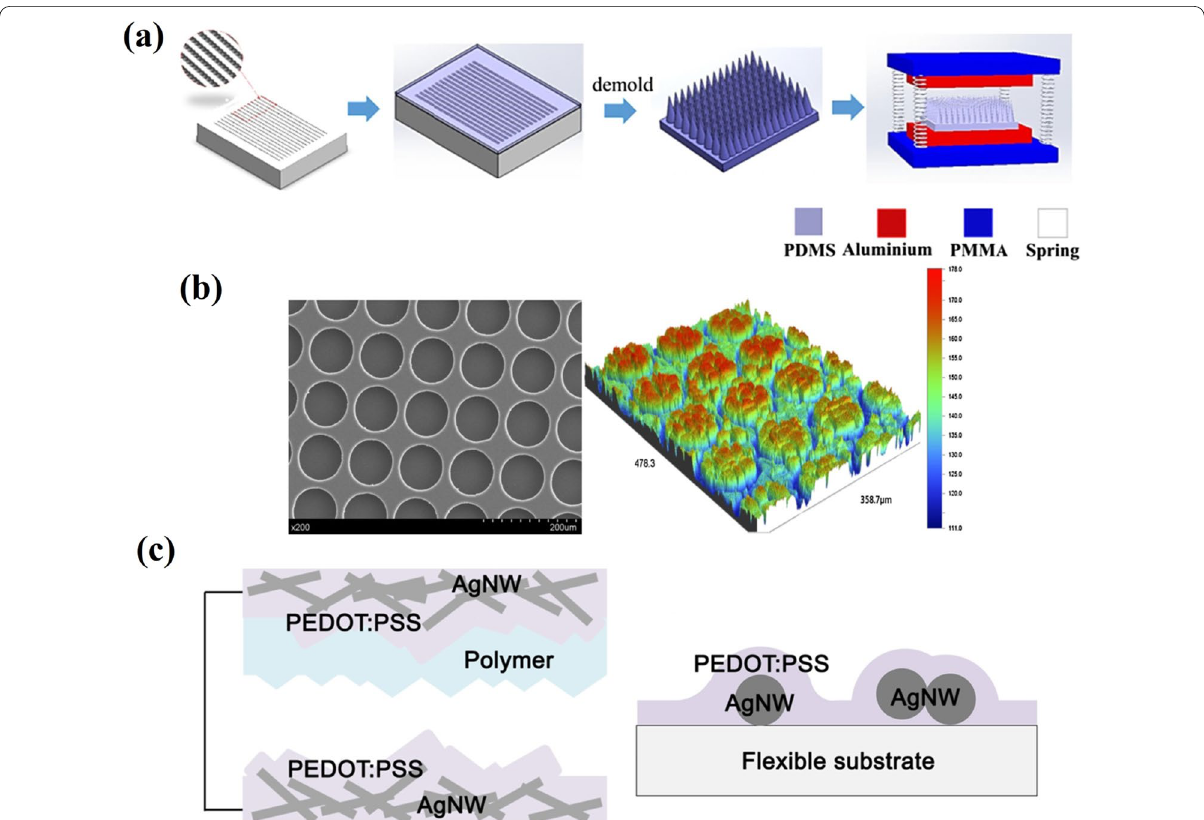
Fig. 9 Surface micro-/nano-patterning techniques: a a schematic fabrication of the overlapped microneedles arrayed PDMS and the assembly of Al/PDMS MN-TENG (Reproduced with permission from Ref. [71]); b SEM image of the patterned PDMS before plasma treated and the topography of the pattern PDMS film treated by plasma (Reproduced with permission from Ref. [72]); c diagrams showing TF-TENG with embedded AgNWs in the PEDOT:PSS layer and the enlarged cross-sectional view of PEDOT:PSS/AgNW layer on a substrate (Reproduced with permission from Ref.